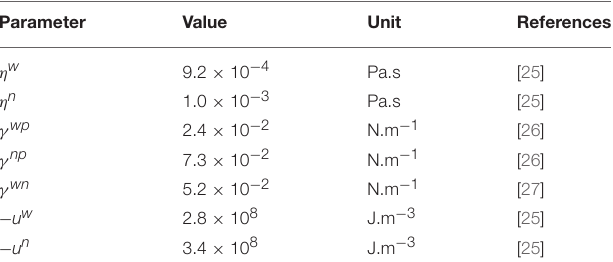
TABLE 1 | Fluid properties used to compute the candidate REV internal energy, for a network containing water (n) and decane (w) within silica glass beads (p) at atmospheric pressure and 293